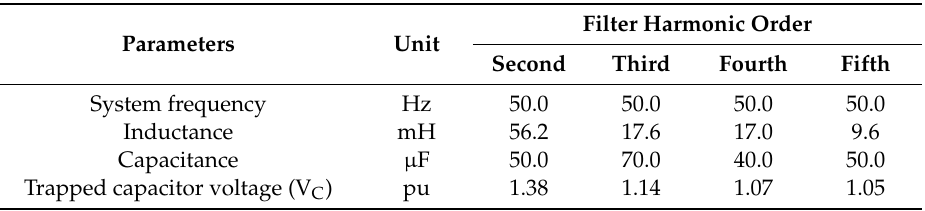
Table 2. Trapped capacitor voltage for filter banks.